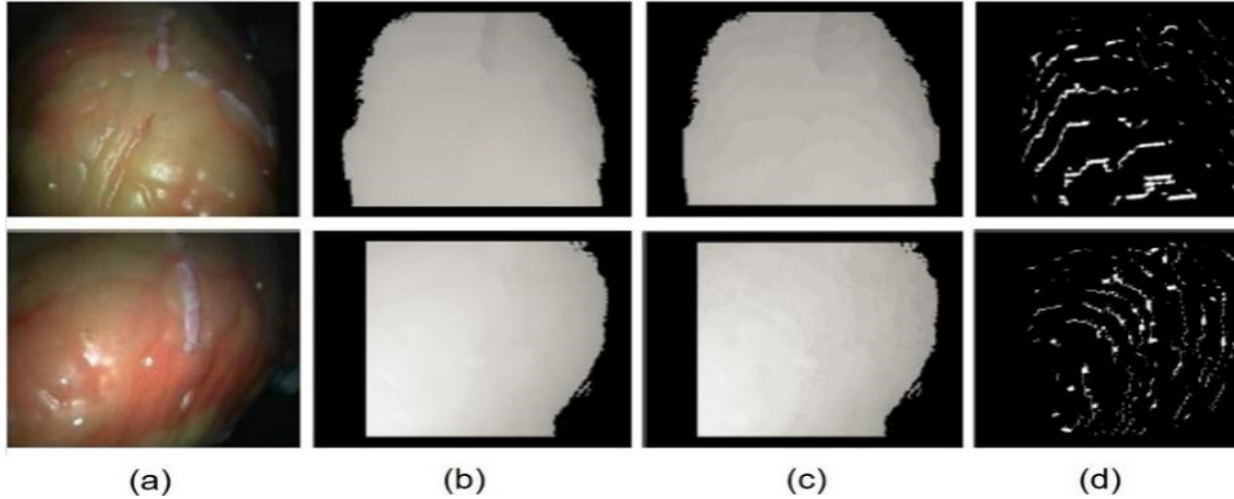
Figure 8. Images and their matching results. ( a ) The left map of the heart model; ( b ) standard parallax map; ( c ) final result disparity map; ( d ) distribution of mismatching points.